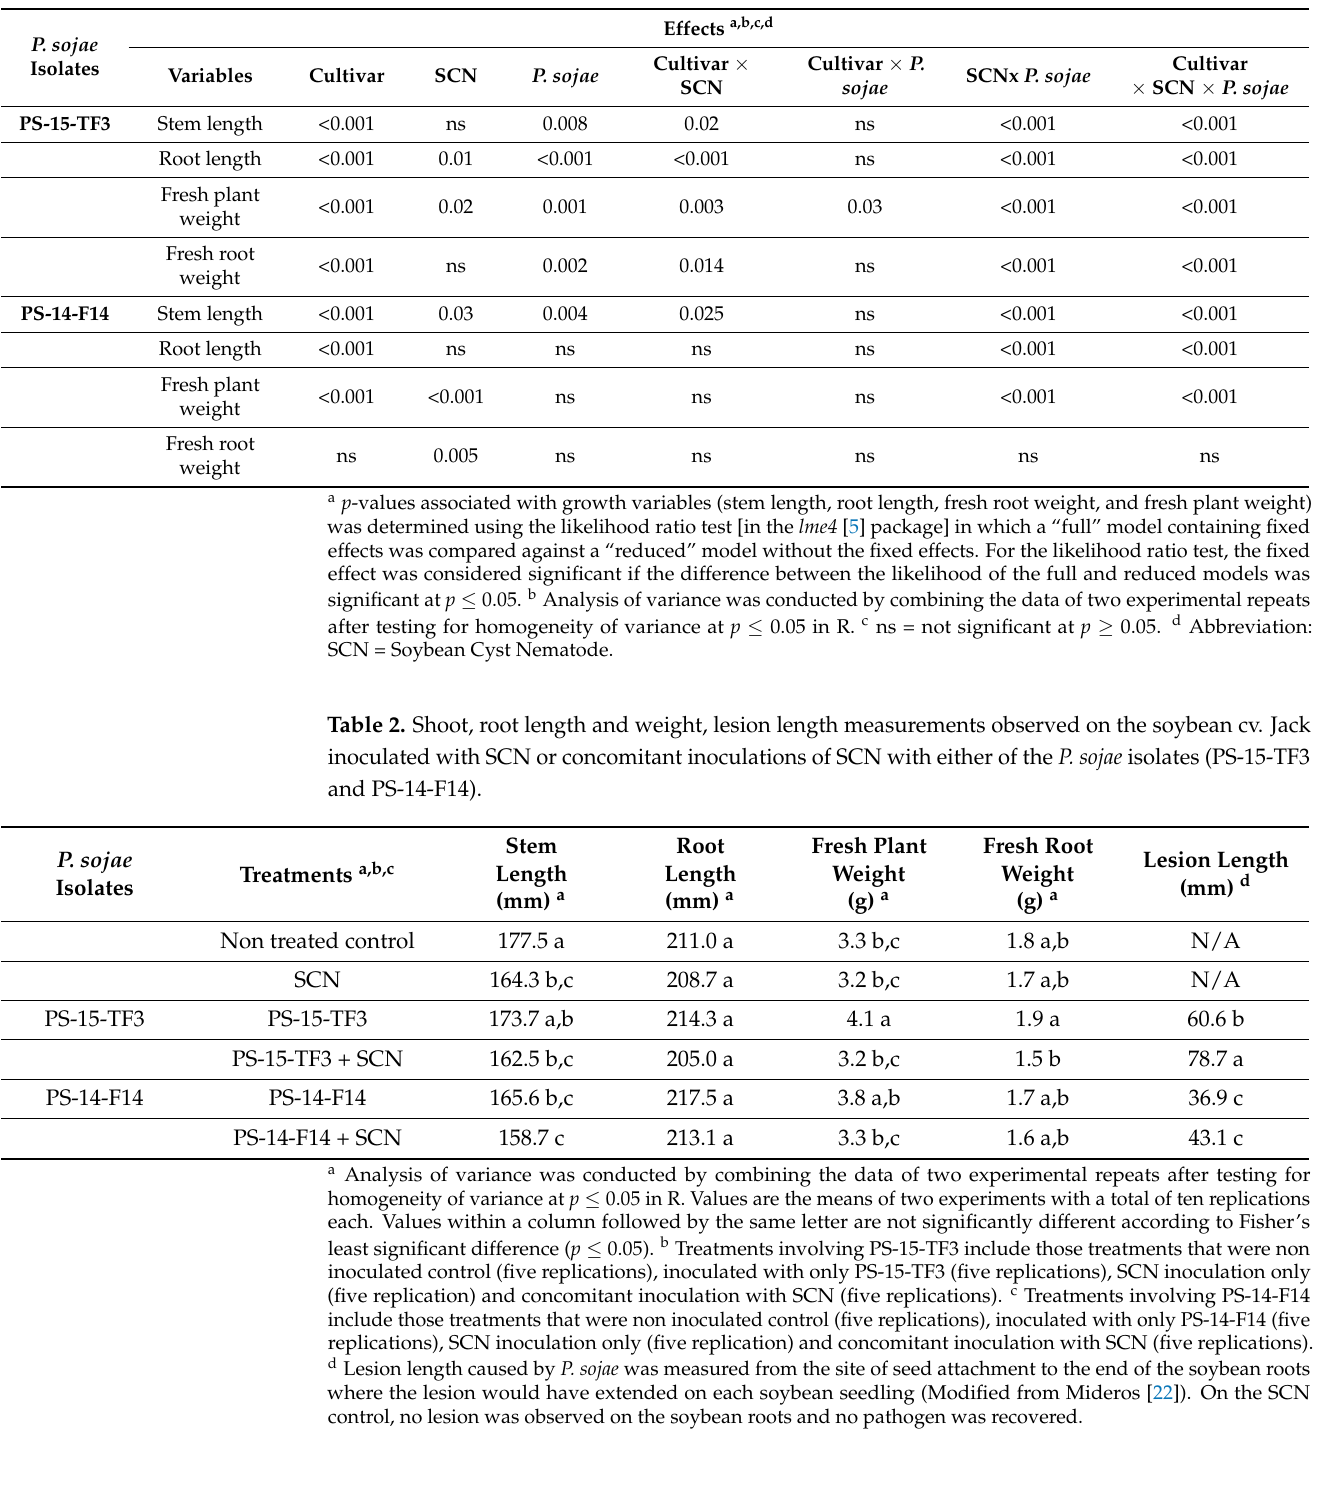
Table 1. p values for main and interaction effect of cultivars (Jack, Surge, William 82, and Williams) and pathogen treatments [SCN, P. sojae isolates (PS-15-TF3, PS-14-F14) or concomitant inoculations of the two pathogens] on soybean growth.